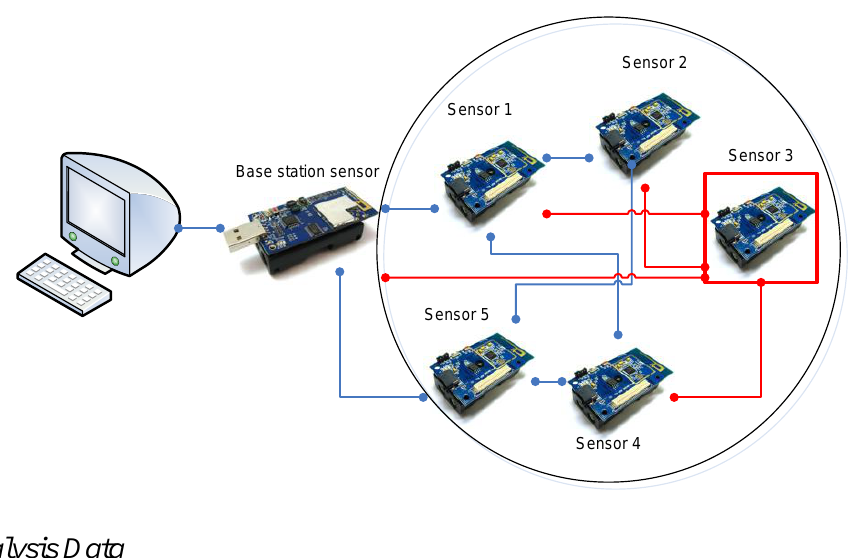
Figure 2. Test-bed environment.